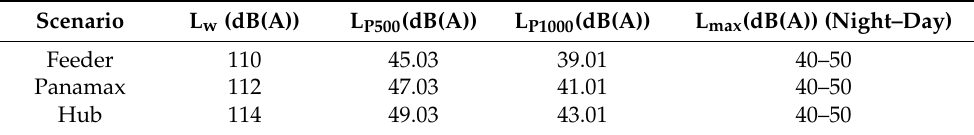
Table 3. Results of noise pollution for the terminal container of the Port of